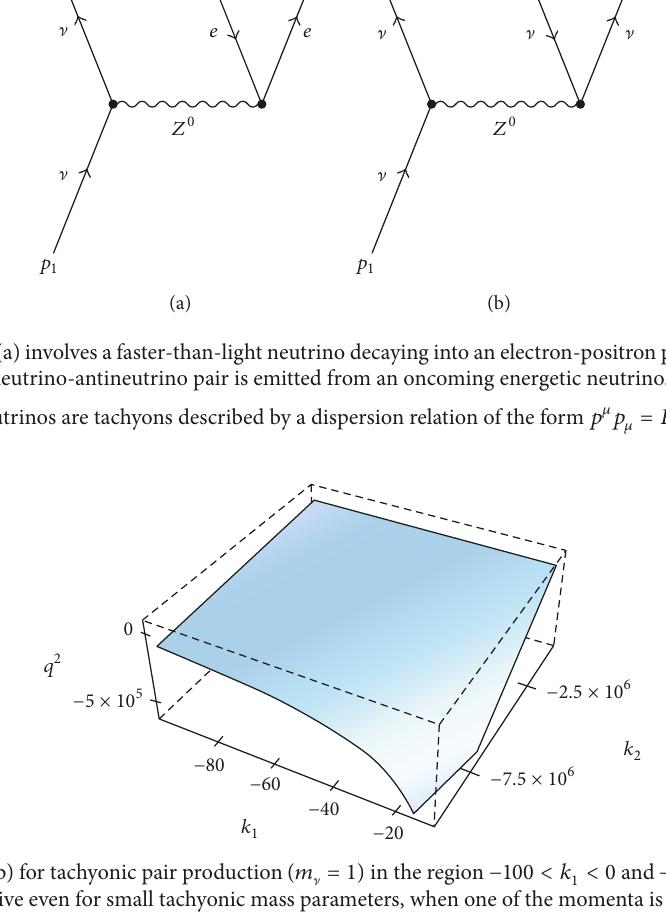
Figure 2: Plot of 𝑞 2 given in (3b) for tachyonic pair production (𝑚 ] = 1) in the region −100 < 𝑘 1 < 0 and −10 7 < 𝑘 2 < 0 , demonstrating that 𝑞 2 may become large and negative even for small tachyonic mass parameters, when one of the momenta is significantly larger than the other (see